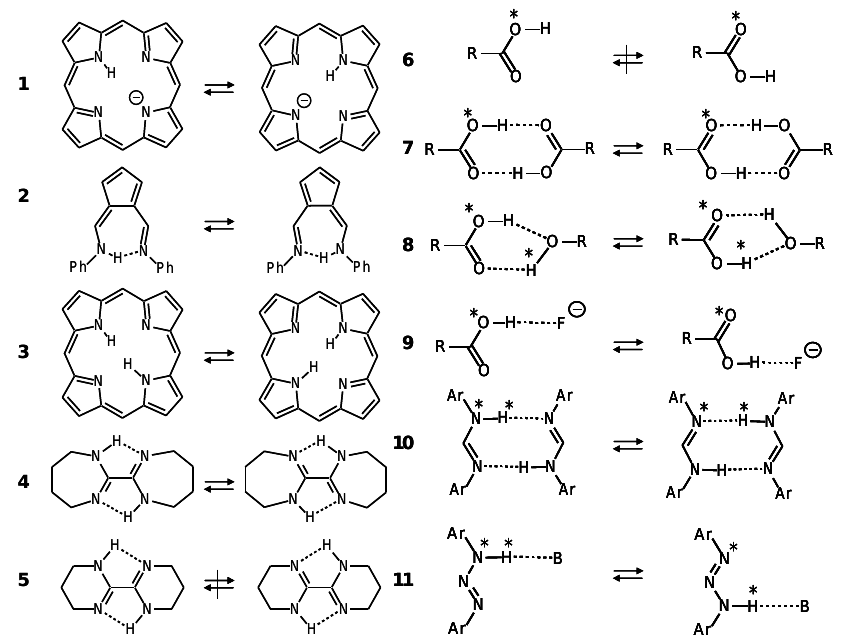
Figure 2. Tautomerism of the porphyrin anion 1 [13], solid N , N ′-diphenyl-6-aminofulvene-1-aldimine 2 [14], porphyrin 3 , bicyclic oxalamidines 4 and 5 [15,16], carboxylic acid monomer 6 , carboxylic acid dimer 7 [17,18], acetic acid/methanol 8 [19], acetic acid/fluoride 9 [20], N , N ′-diarylamidines 10 [21–23] and N , N ′-diaryltriazene/triethylamine 11 [24].